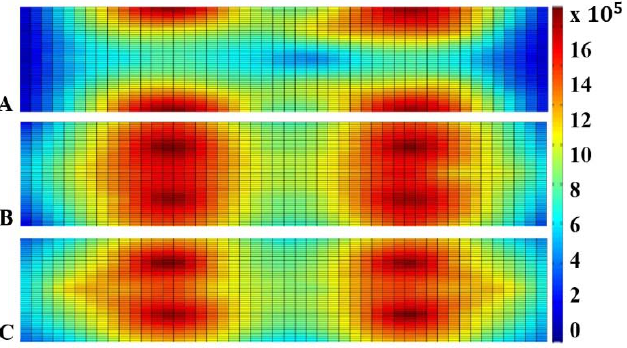
Figure 2. Air anion concentration by generation position: ( A ) sideward, ( B ) upward, and ( C ) down ‐ ward.